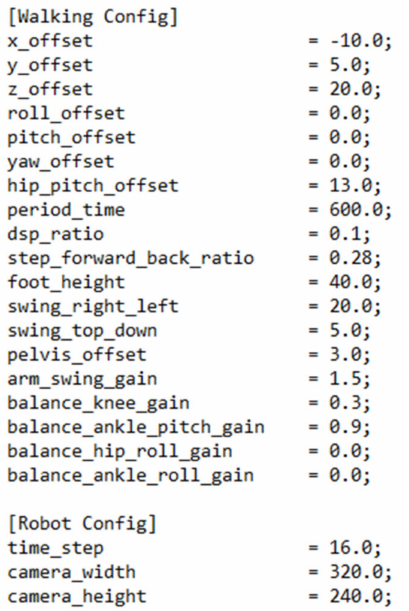
Figure 20. Default parameters in the “config.ini” file [55]. The results for walking obtained with the proposed framework and Robotis-OP2’s walking algorithm [60] are compared as in Figures 21 and 22.